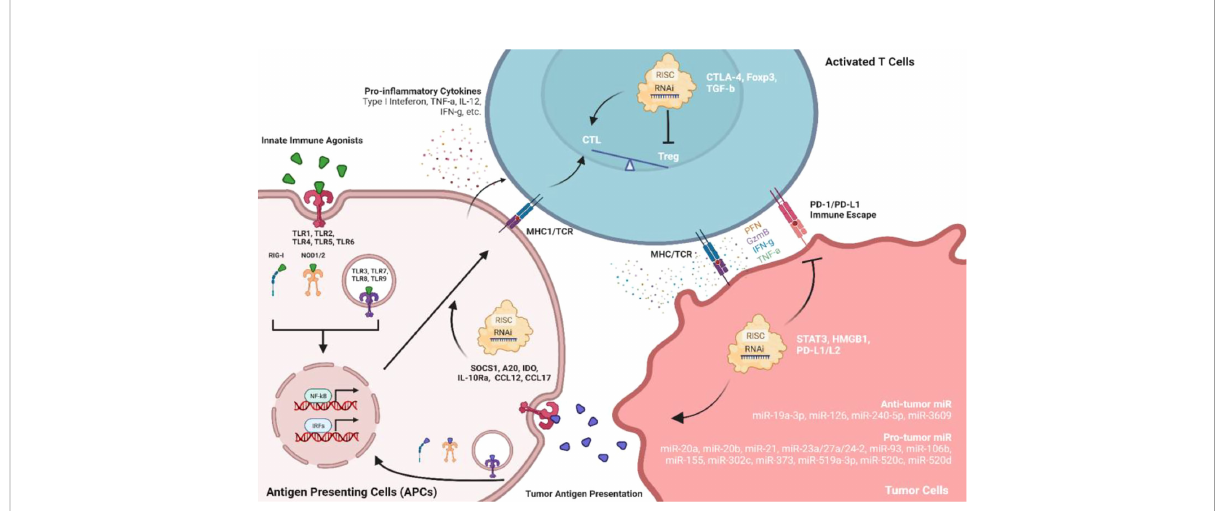
FIGURE 3 Role of innate immune agonists and RNAi in facilitating antitumor immune responses among APCs, T cells, and TMEs. Agonists of pattern recognition receptors (PRRs) on antigen-presenting cells can directly activate the immune system against tumors. Meanwhile, RNAi therapeutics targeting immunomodulatory factors or non-coding RNAs may also facilitate antitumor